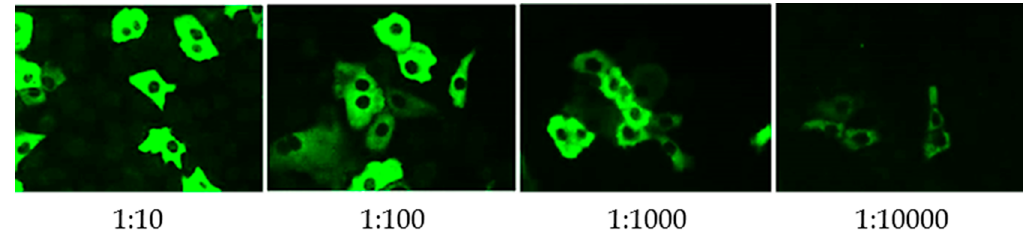
Figure 1. Toscana virus IgG antibodies detected using indirect immunofluorescence assay in a patient (case 3) with neuroinvasive infection.